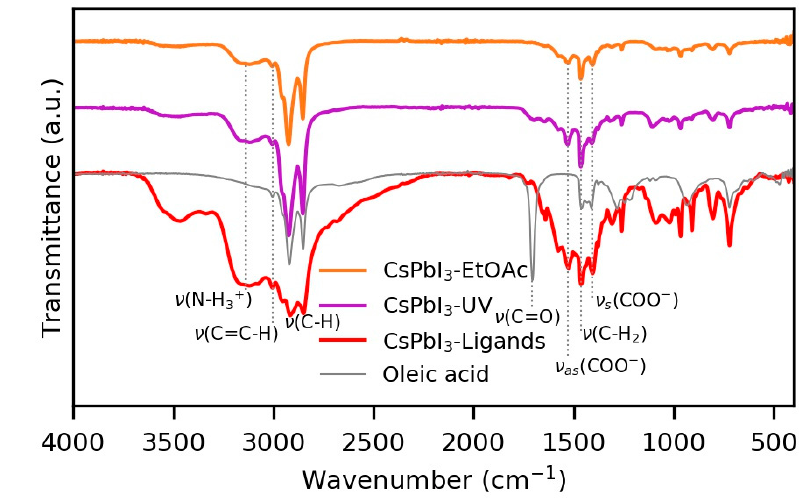
Figure 4. FTIR spectra of neat oleic acid (gray) and spin-coated CsPbI 3 QDs film (without EtOAc washing of the film): CsPbI 3 Ligands (red); spin-coated film washed with EtOAc: CsPbI 3 -EtOAc (orange). Spin-coated layer exposed to UV light for 2 min after washing: CsPbI 3 -UV (purple). In all the cases the film constituted of 1 spin-coated layer of QDs.